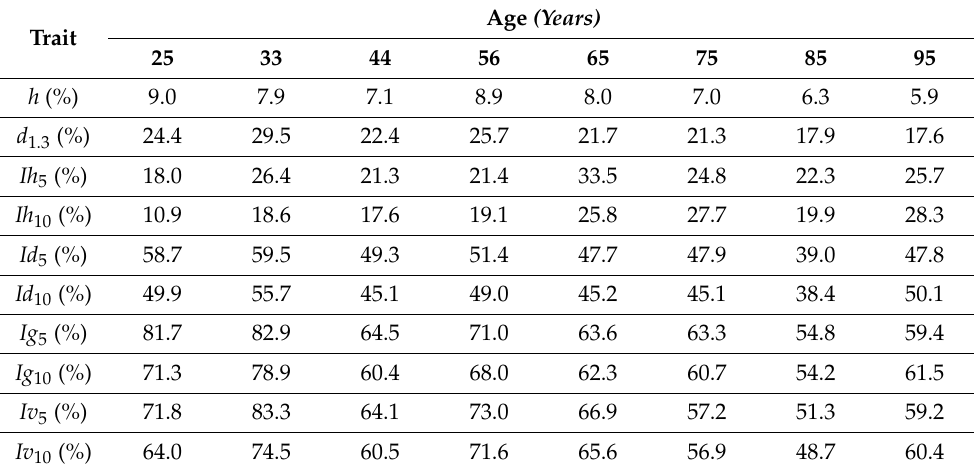
Table 3. Coefficients of variation for dendrometric and increment traits. Trait